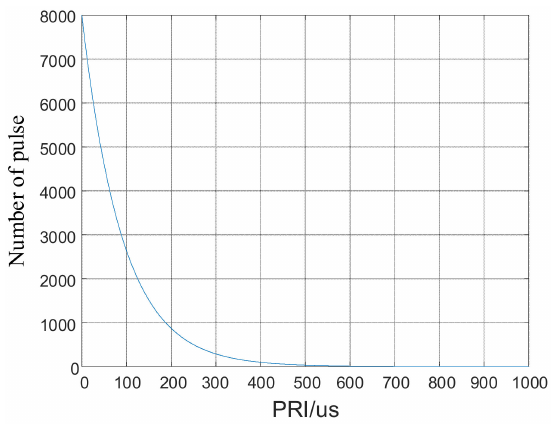
Figure 1. Schematic diagram of the threshold